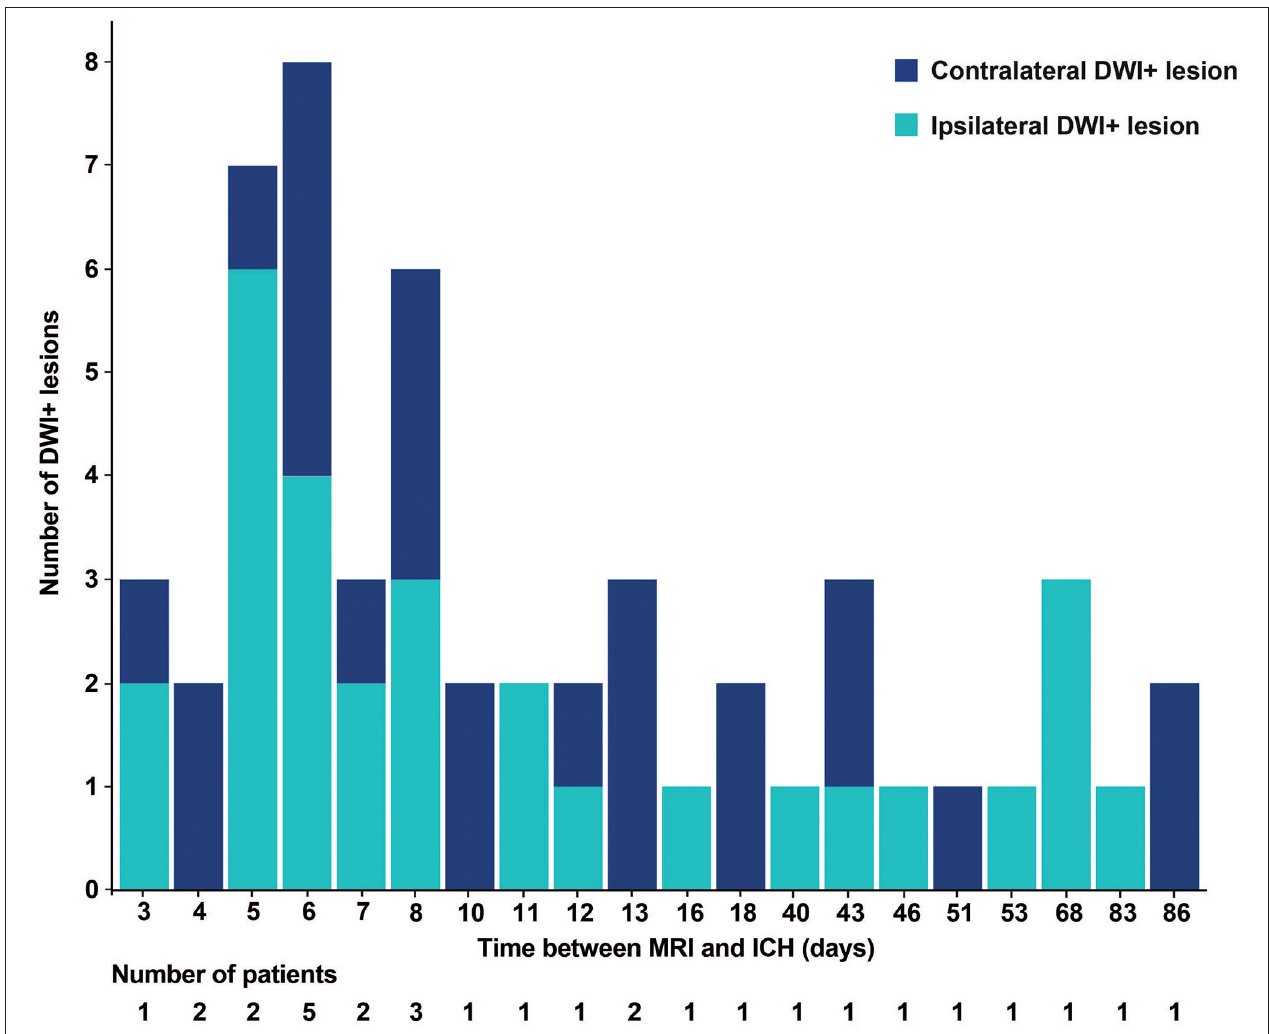
FIGURE 2 | Histogram of the number of DWI + lesions and time between MRI and ICH. DWI + , diffusion-weighted imaging-positive. MRI, magnetic resonance imaging; ICH, intracerebral hemorrhage.